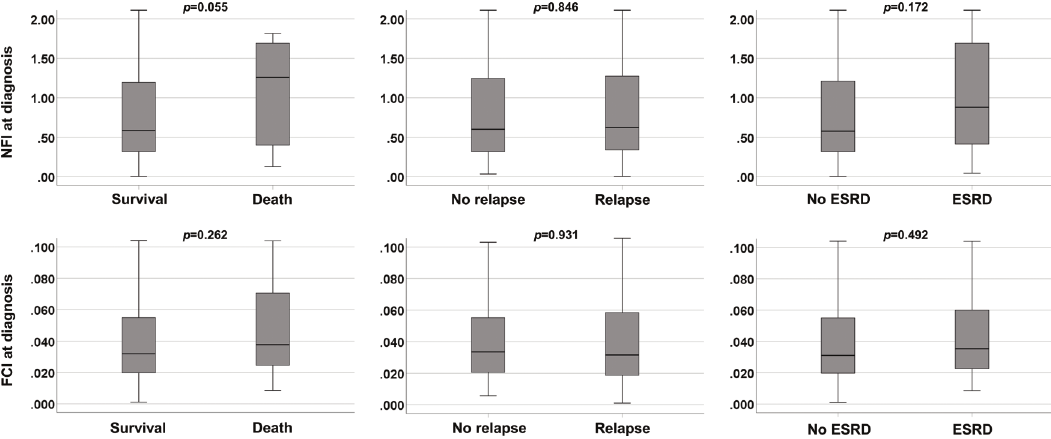
Figure 1 - Comparison of FCI and NFI at diagnosis based on each poor outcome. Among six conditions, only NFI at diagnosis in deceased AAV patients tended to be increased compared to survived AAV patients, but it did not reach a statistical significance. NFI: